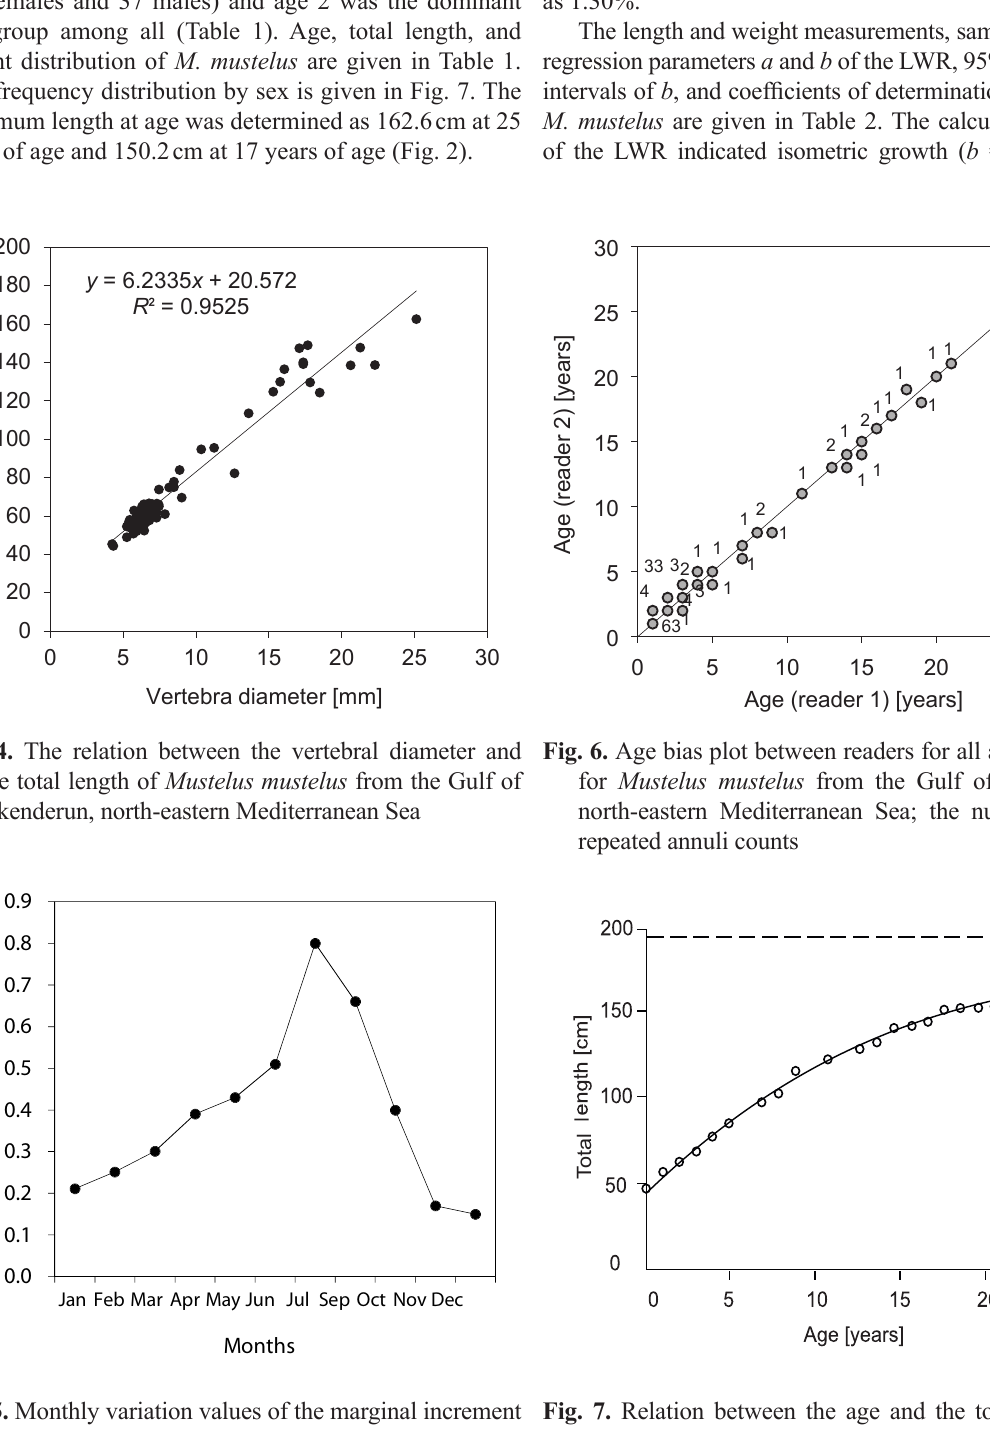
Fig. 5. Monthly variation values of the marginal increment ratio of Mustelus mustelus from the Gulf of Iskenderun, north-eastern Mediterranean Sea